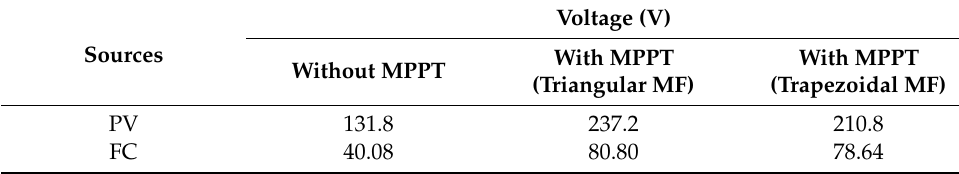
Table 3. Comparative analysis for with and without